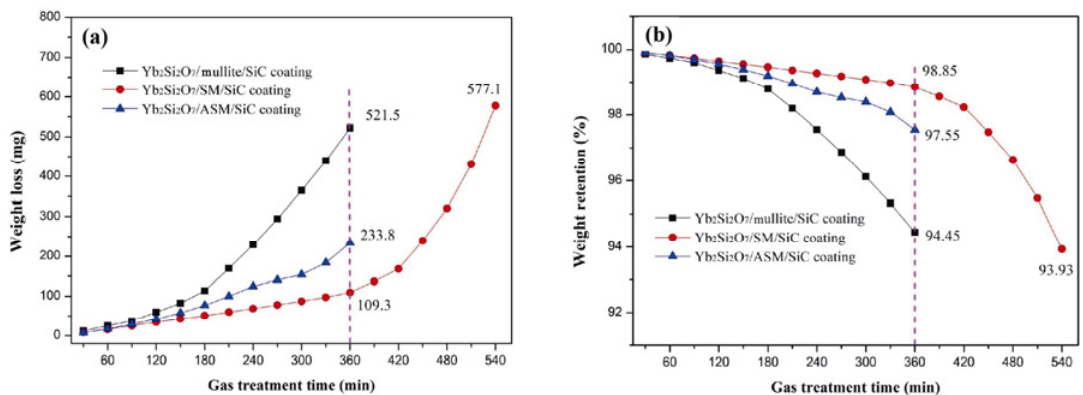
Fig. 13 (a) Weight losses and (b) retention of tri-layer Yb 2 Si 2 O 7 /mullite/SiC, Yb 2 Si 2 O 7 /SM/SiC, and Yb 2 Si 2 O 7 /ASM/SiC coatings- coated C f /SiC samples in the burner rig test at 1673 K. Note: 15 min represents one